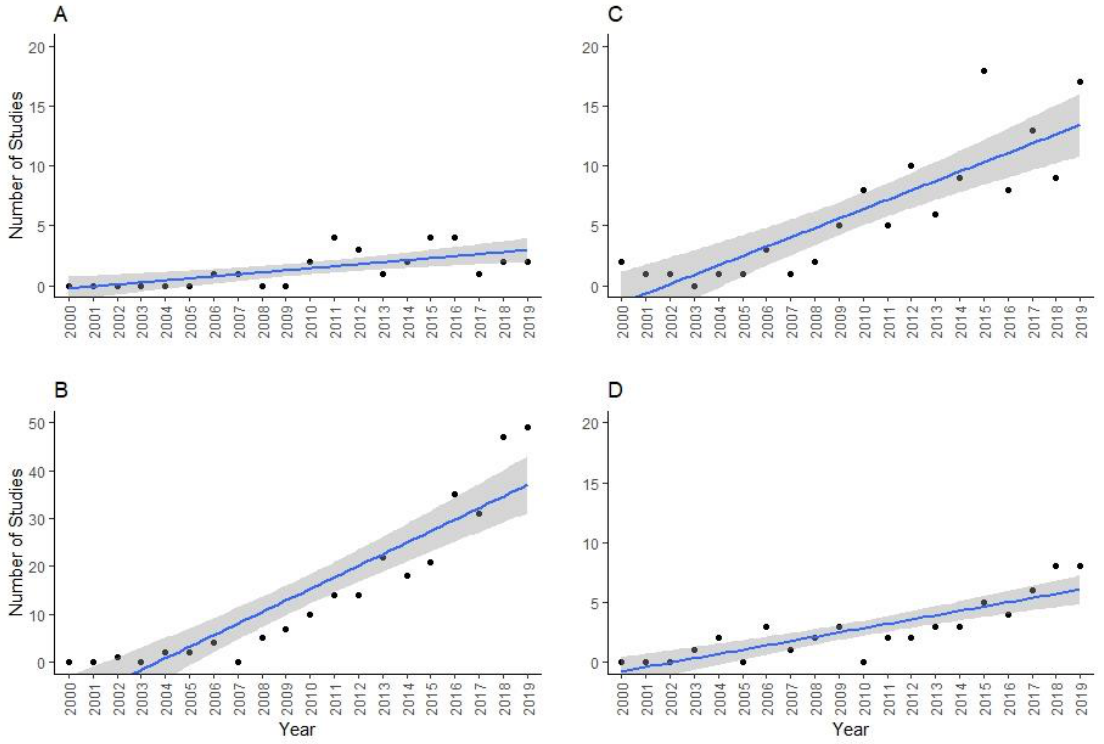
Figure A 2 .2: Number of disaster-related papers with community-engaged research frameworks or methodologies for the disciplines of ecology (A), psychology (B), public health (C), and economics (D). Each plot has fitted linear regression lines, with shaded areas representing 95% confidence